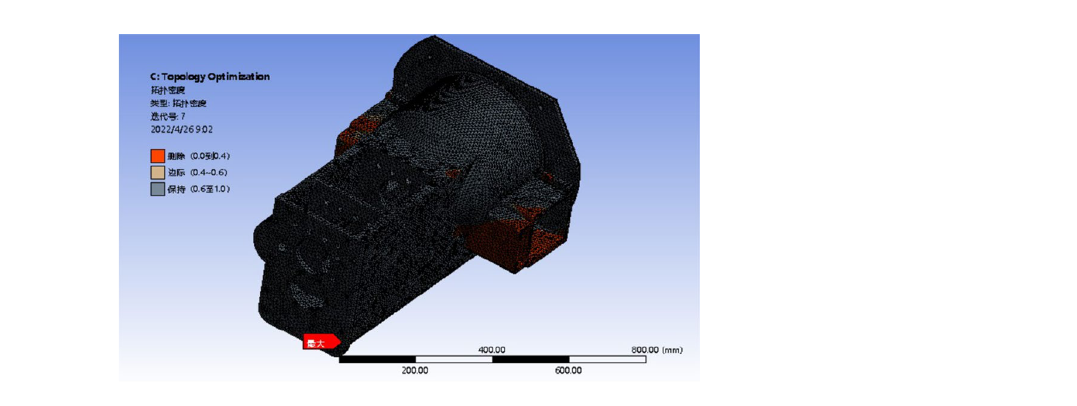
Figure 13. Optimization results with 10% mass